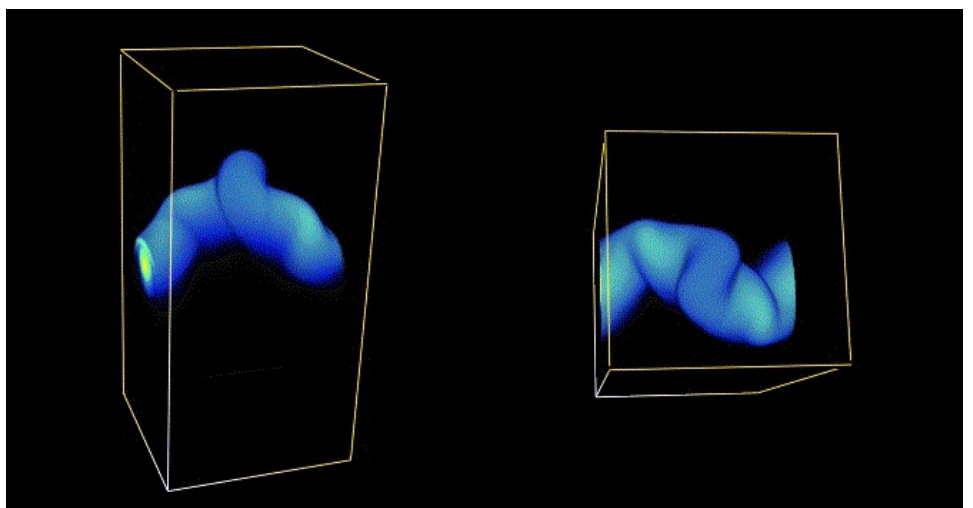
Figure 40: Still from a movie showing Volumetric rendering of a rising flux tube experiencing the devel- oping of the helical kink instability (Fan et al. , 1998). (To watch the movie, please go to the online version of this review article at http://www.livingreviews.org/lrsp-2014-3